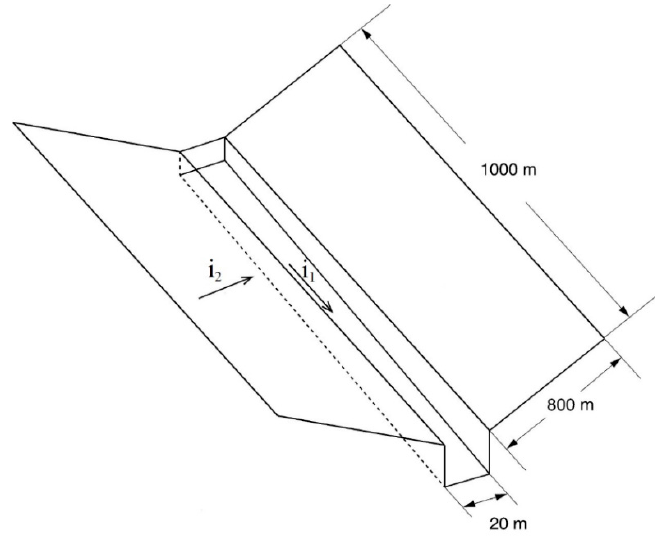
Figure 1. Geometry of the V-shaped channel.